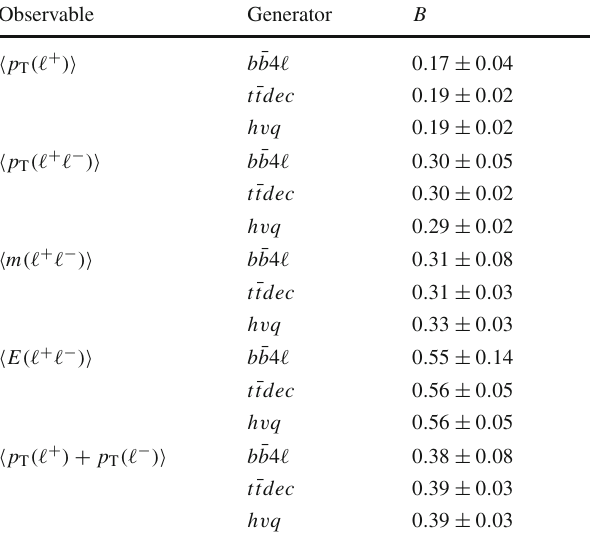
Table 21 Impact of MEC in Pythia8.2 on the leptonic observables for the different NLO+PS generators